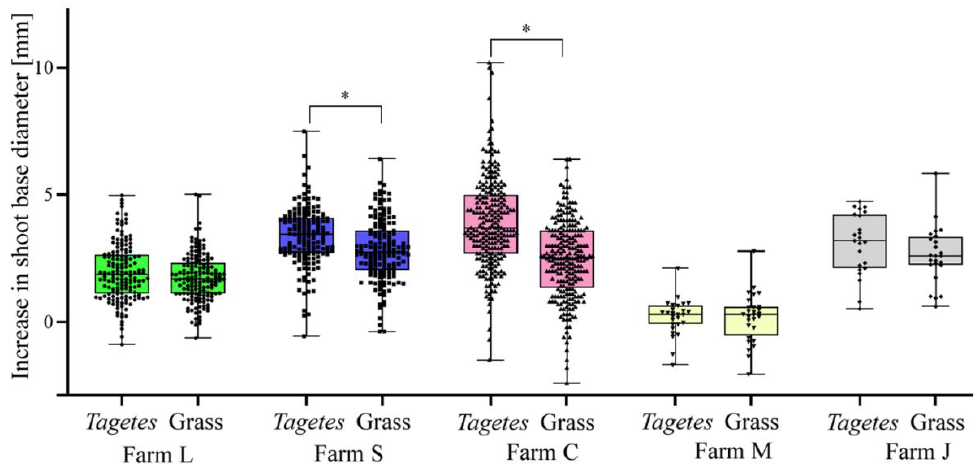
Figure 1. Increase in shoot base diameter of apple plants grown in ARD soils that were pre-cultured with Tagetes or grass. Crosses indicate means; boxes indicate medians and quartiles; stars indicate significant treatment effects as revealed by the respective contrasts in a generalized linear mixed model ( p < 0.05).